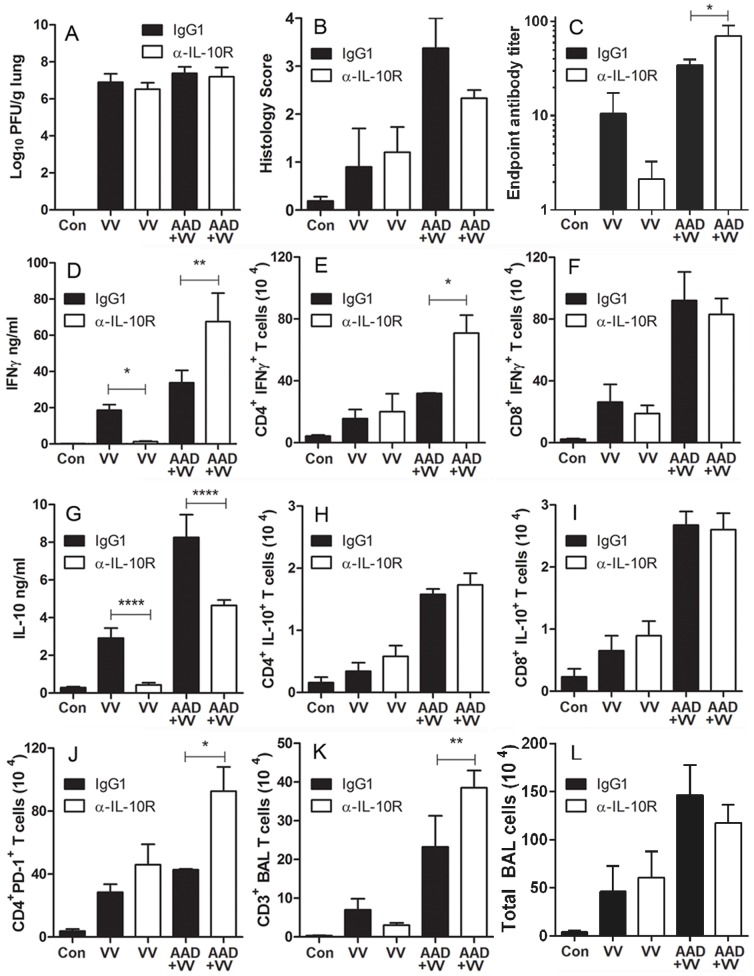
Blocking IL-10R signaling in VV-infected AAD mice resulted in altered disease severity.VV-infected mice were treated with Rat IgG1 control mAb or αIL-10R blocking mAb at 3 (i.p.), 4 (i.n.) and 6 dpi (i.p.), and these animals were sacrificed on day 9. (A) Lung VV titers and (B) bronchiole inflammation were not altered by IL-10R mAb blockade. Blocking IL-10R signaling increased (C) levels of VV-specific IgG1 in serum, (D) IFNγ protein levels in BAL fluid and (E) the frequency of infiltrating CD4+ IFNγ+ T cells in the lungs of VV-infected AAD mice. Treatment with an αIL-10R mAb did not alter the infiltration of (F) CD8+ IFNγ+, (H) CD4+ IL-10+ or (I) CD8+ IL-10+ T cells, butincreased recruitment of (J) CD4+ PD-1+ T cells in the lungs of VV-infected AAD mice. Blocking IL-10R significantly decreased (G) BAL IL-10 protein secretion and significantly increased (K) BAL T cells but not (L) total BAL cells in VV-infected mice with AAD. Statistical significance was determined by a One-way ANOVA with Bonferroni’s multiple comparisons test: *P<0.05, **P<0.01, ****P<0.0001 αIL-10R mAb vs. IgG1. Results are expressed as the mean ± SEM for 3–5 mice in each group and are representative of 2 independent experiments.